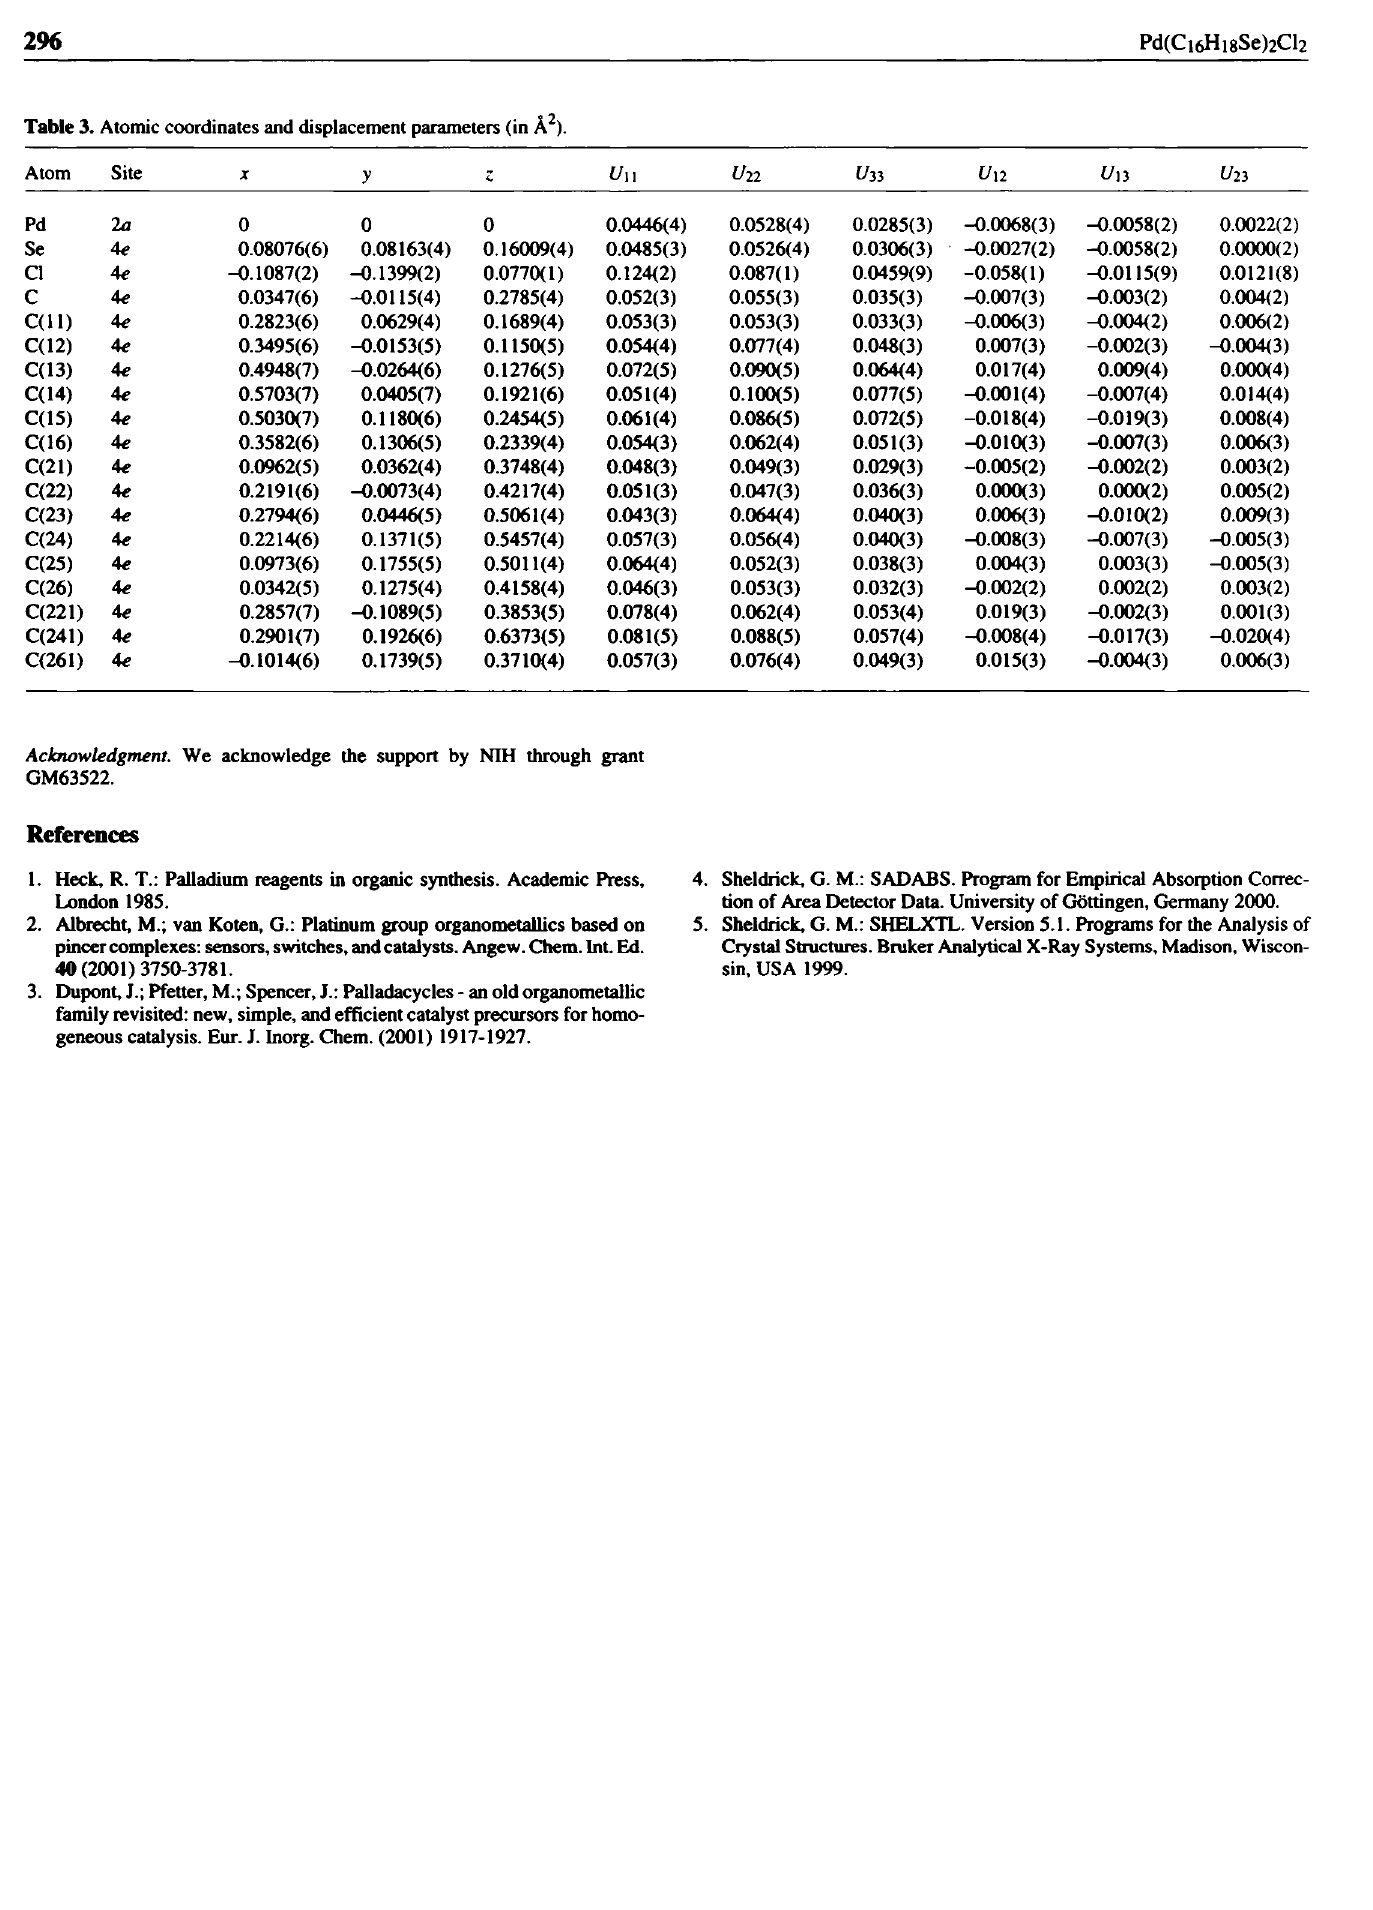
Table 3. Atomic coordinates and displacement parameters (in Ä 2